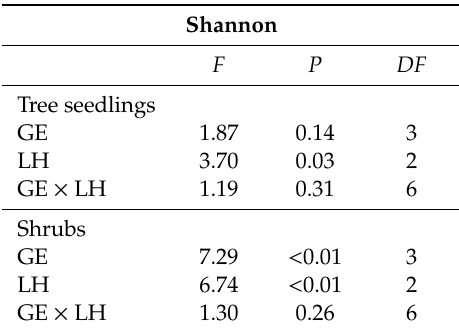
Table 3. E ff ects of landscape heterogeneity (LH) and gap / forest environment (GE) on alpha-diversity indices for tree seedling and shrub species.